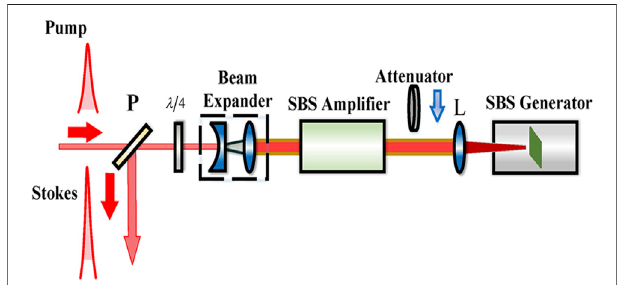
FIGURE 5 | Schematic diagram of compact two-cell structure.